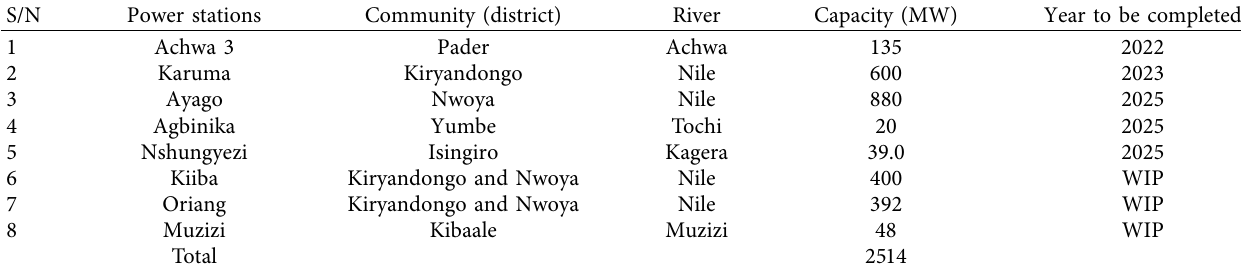
Table 5: Proposed and under construction large hydropower plant [118, 119].